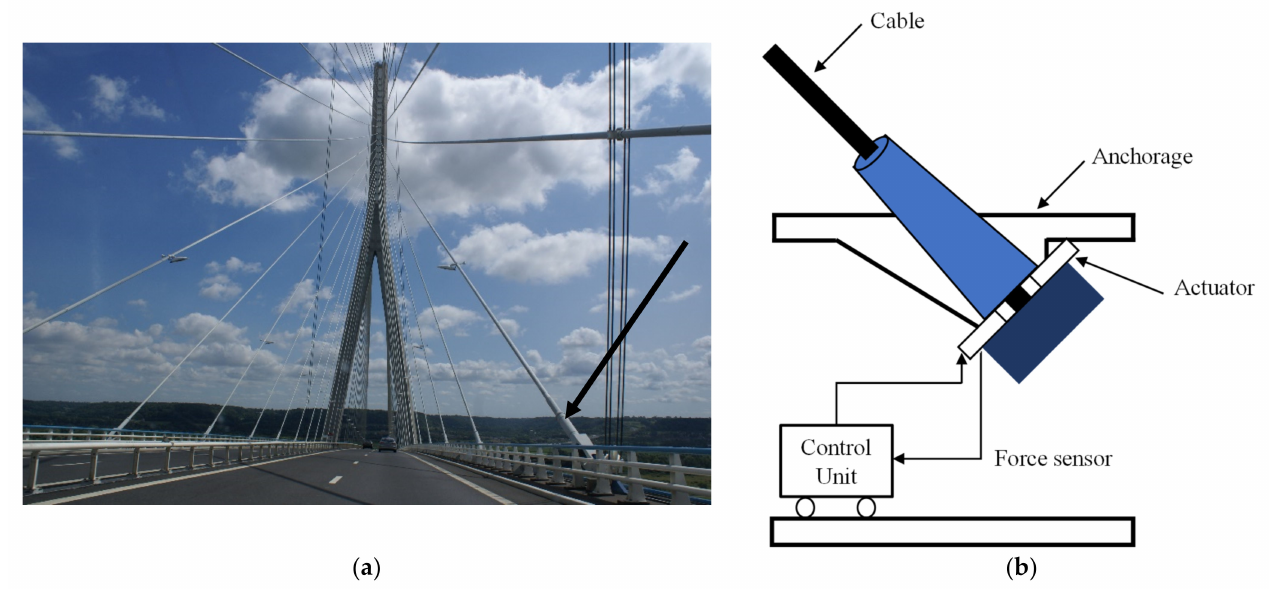
Figure 18. ( a ) Normandy Bridge equipped with active tendon cable https://upload.wikimedia. org/wikipedia/commons/c/cc/Pontdenormandie.JPG (access on 15 October 2022); ( b ) active ten- don